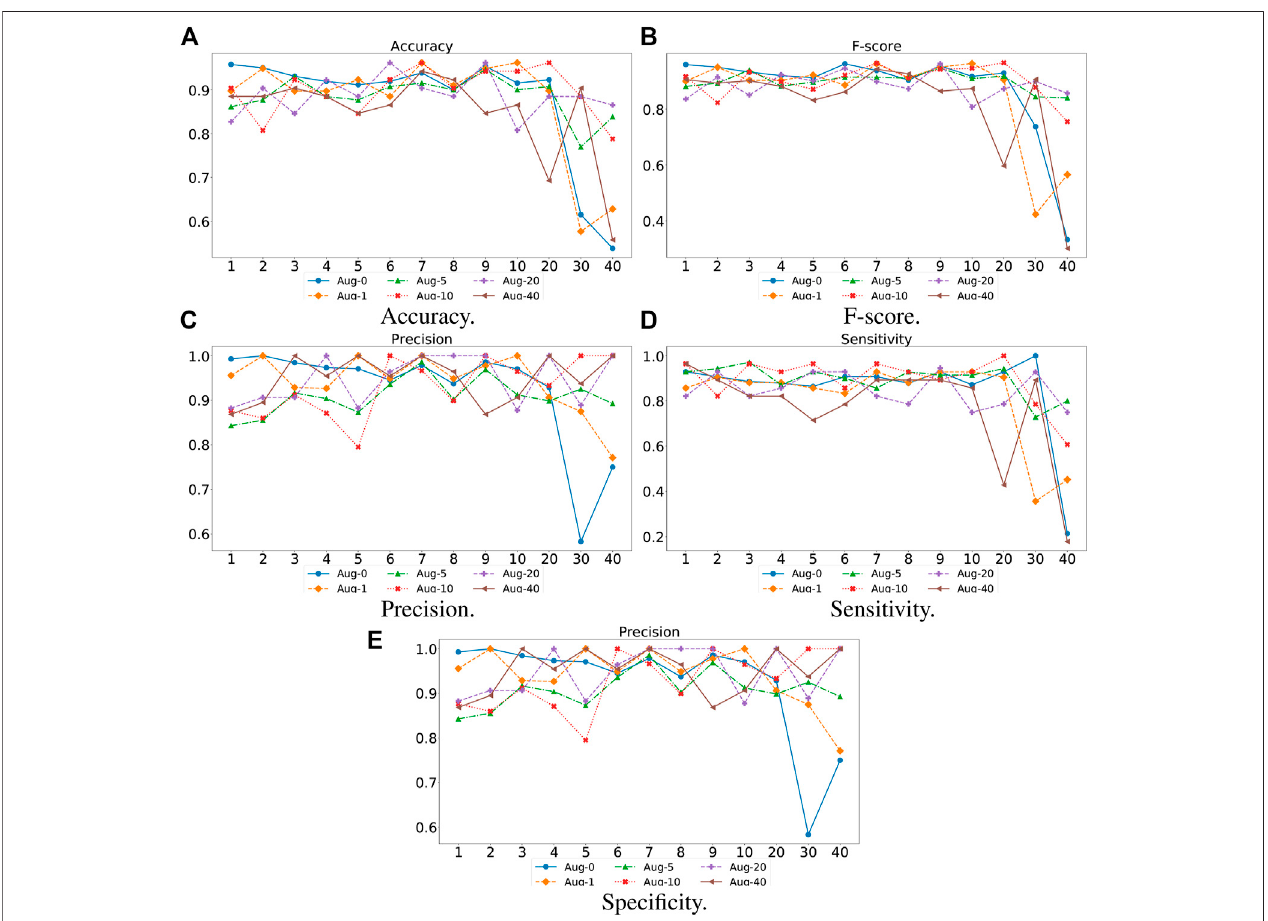
FIGURE4| Performance ofdifferentaugmentationfactors (0, 1,5,10, 20,and 40)with varying N ,the number ofidenticallayersinTransHFO framework,from 1to 40. (A) Accuracy. (B) F-score. (C) Precision. (D) Sensitivity. (E) Speci fi city.